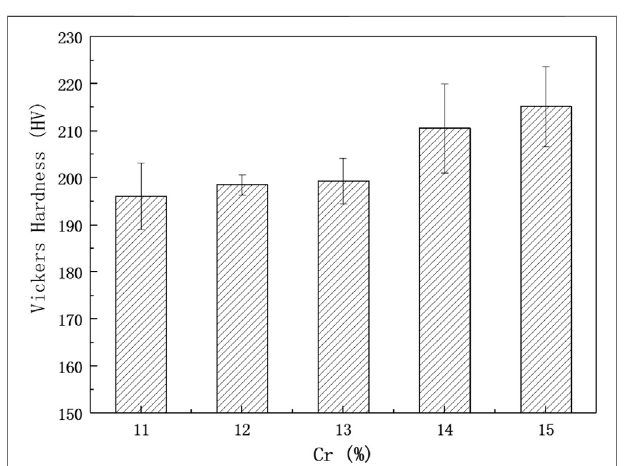
FIGURE 10 | The relationship between CTE and temperature of Fe – x Cr – 6Al